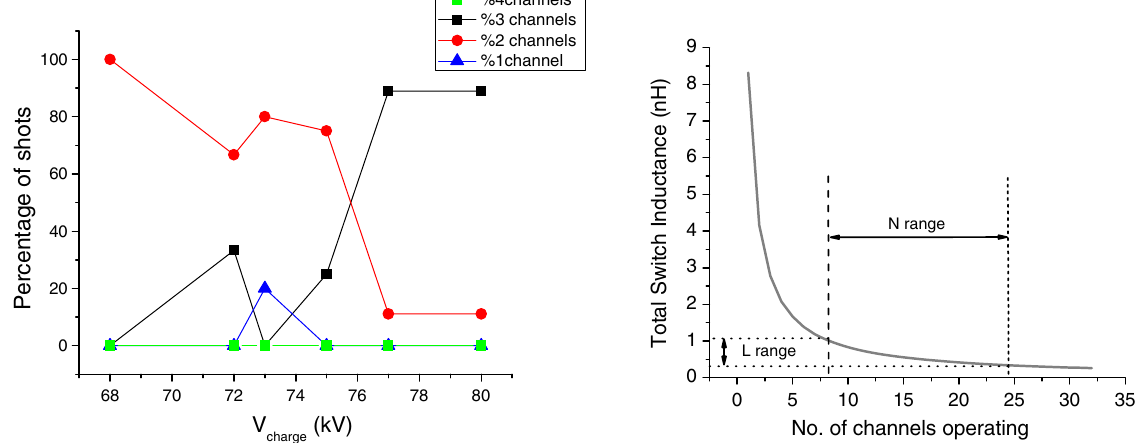
FIG. 5. Inductance as a function of channel number N , and variation of number of channels observed to operate as a function of charge